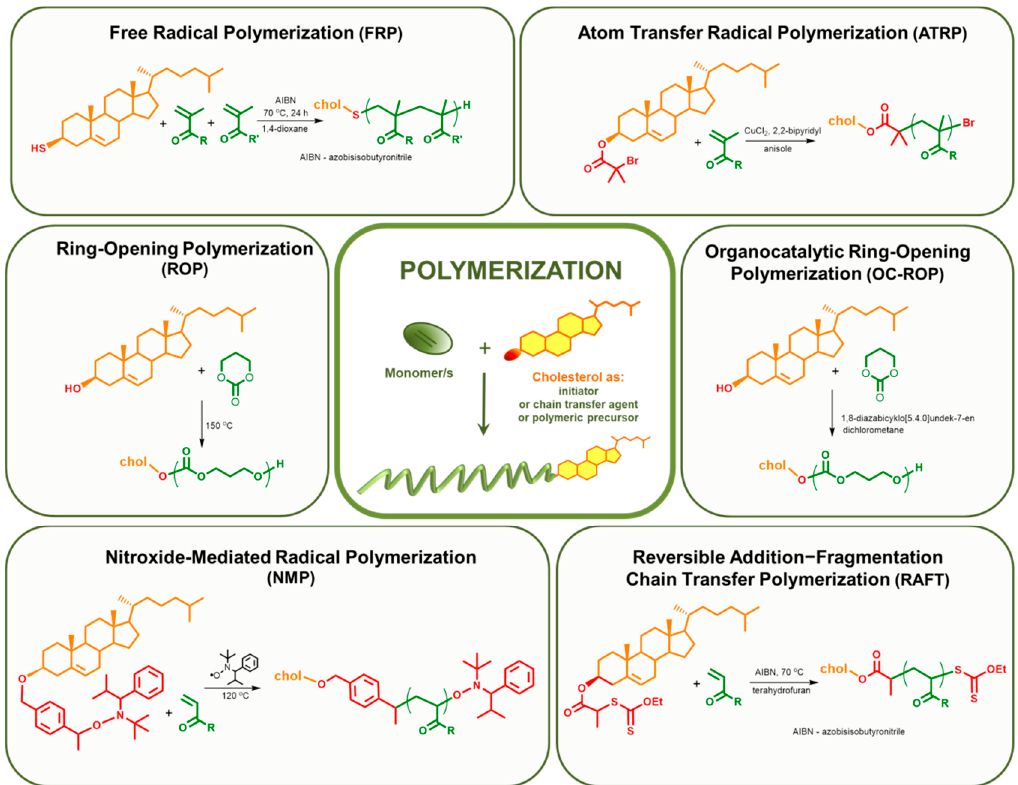
Figure 3. Polymerization methods used for the synthesis of cholesterol end-capped polymers and reaction examples [24,52,54,91,99–101].